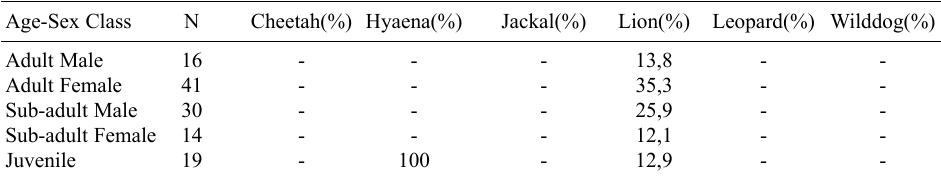
Proportional predation mortality of buffalo Syncerus caffer relative to each age and sex class,